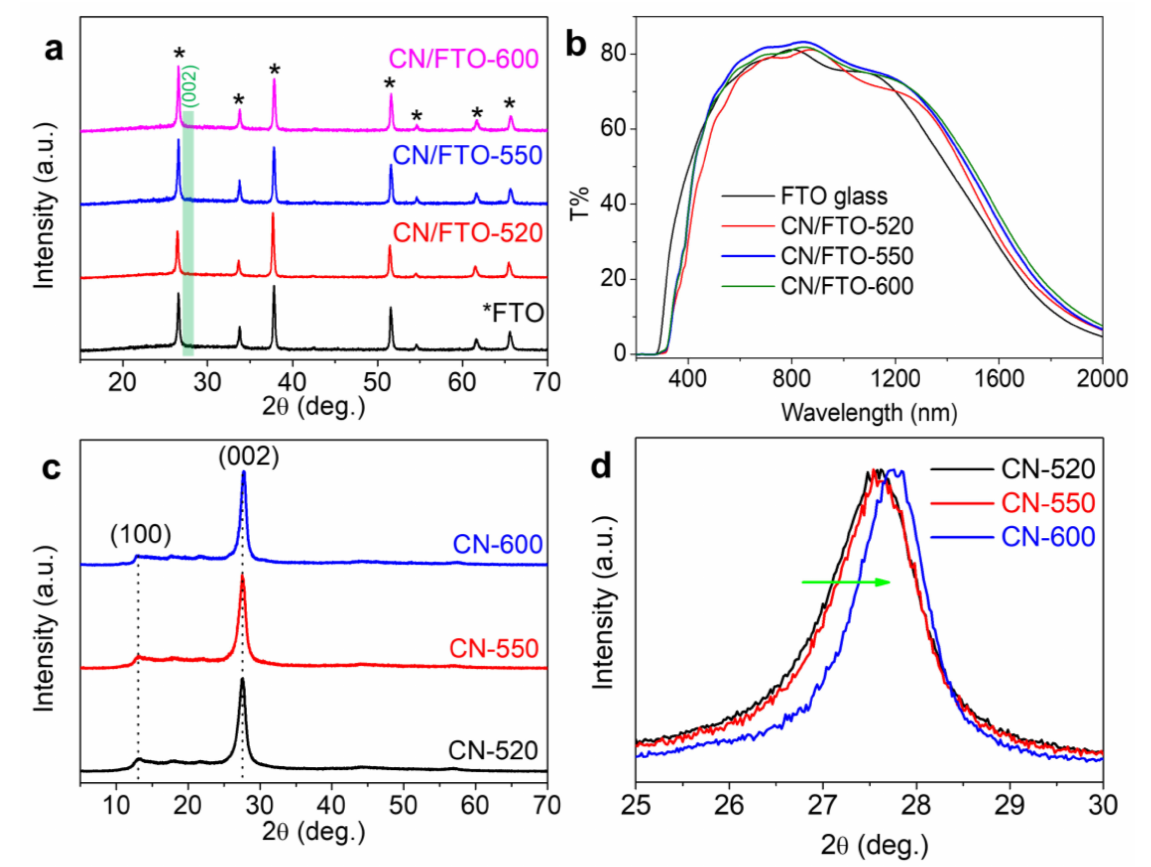
Figure 3. ( a ) XRD patterns and ( b ) transmittances of CN/FTO films. ( c ) CN powders obtained at 520, 550, and 600 ◦ C. ( d ) Overlap XRD patterns to show the peak